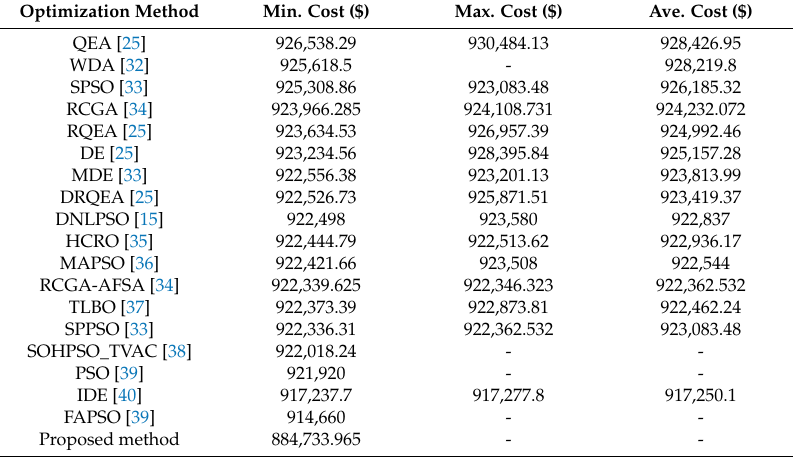
Table 2. Comparisons of simulation results for test system 1, case 1. Employing quantum-inspired evolutionary algorithm (QEA); quantum-inspired evolutionary algorithm (WDA); small population-based particle swarm optimization (SPSO); real-coded genetic algorithm (RCGA); real-coded quantum-inspired evolutionary algorithm (RQEA); modified differential evolution (MDE); differential real-coded quantum-inspired evolutionary algorithm (DRQEA); hybrid chemical reaction optimization-differential evolution (HCRO-DE); modified adaptive particle swarm optimization (MAPSO); real coded genetic algorithm and artificial fish swarm algorithm (RCGA-AFSA); teaching learning-based optimization (TLBO); SPPSO; self-organizing hierarchical particle swarm optimization technique with time-varying acceleration coefficients (SOHPSO_TVAC); particle swarm optimization (PSO); improved differential evolution (IDE); fuzzy adaptive particle swarm optimization (FAPSO); dynamic neighborhood learning based particle swarm optimization (DNLPSO) and; modified dynamic neighborhood learning based particle swarm optimization (MDNLPSO).